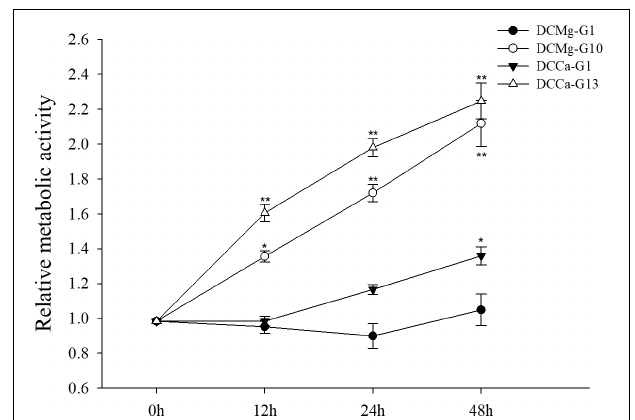
FIGURE 9 | Acute oxygen consumption rate of JSCs under extreme Ca 2 + and Mg 2 + concentrations. Bars (mean ± SE, n = 3) with an asterisk denote a significant difference ( ∗ P < 0.05, ∗∗ P < 0.001) between the test groups and CK.